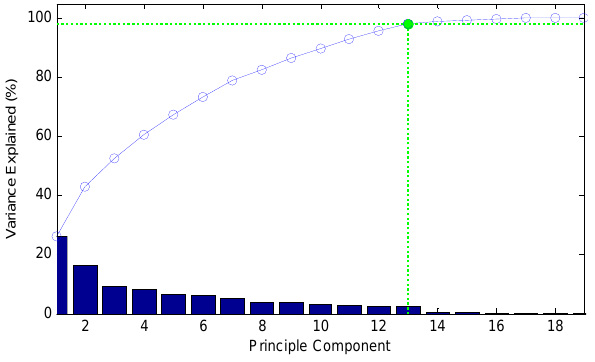
Figure 21. The curve of cumulative sum of variance with